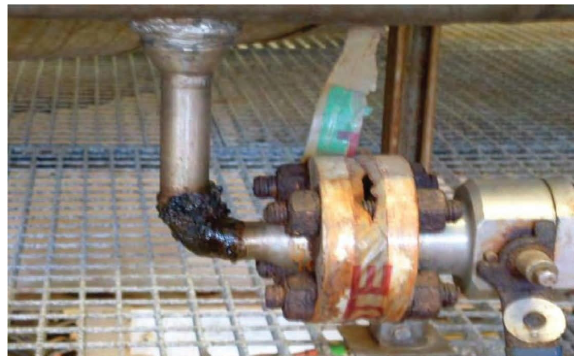
Figure 1: Example of pipeline fatigue